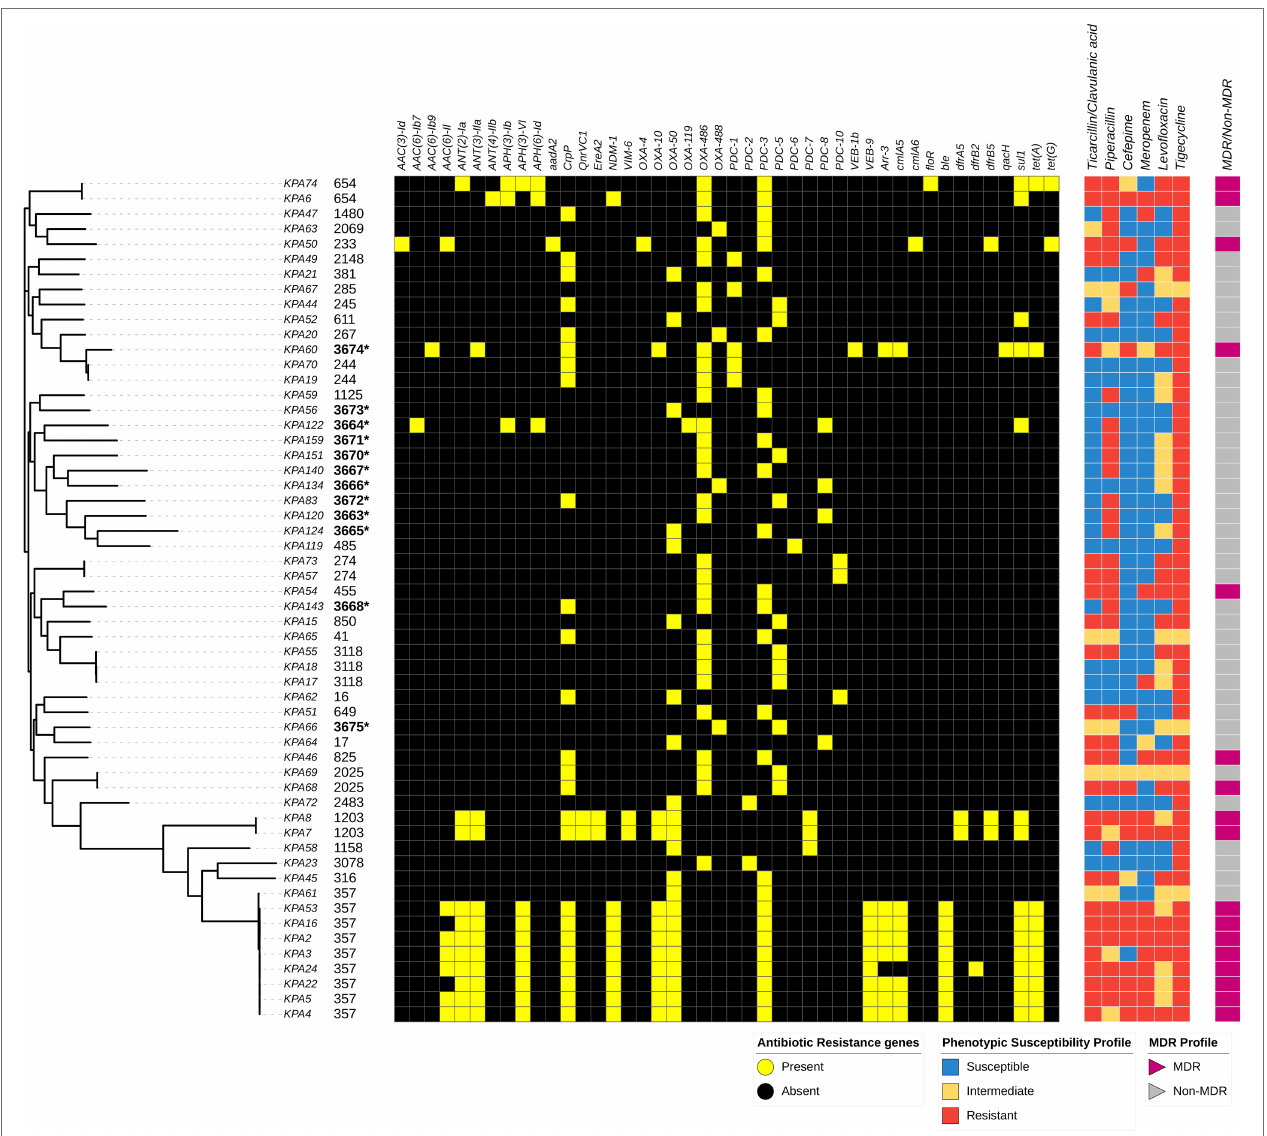
FIGURE 3 | Distribution of sequence types, variably present antibiotic resistance genes, and susceptibility profiles among Pseudomonas aeruginosa isolates mapped on the maximum-likelihood phylogenetic tree of all study isolates, and the presence and absence of resistance genes as detected by the Comprehensive Antibiotic Resistance Database (CARD) is depicted. Associated resistance genes include: Beta lactamases: PDC , NDM-1 , OXA , VEB , & VIM-6 , Phenicols: floR & cmlA , Glycylcyclines: tet , Sulfonamides: – sul , Aminoglycosides: aac , aph , & ant , Fluoroquinolones: – QnrVC1 & crpP , Macrolides: EreA , Trimethoprim: – dfrB , Glycopeptide: ble . Isolates with an asterisk (*) depict novel